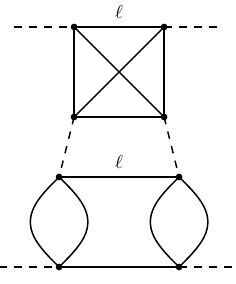
2 : such diagrams